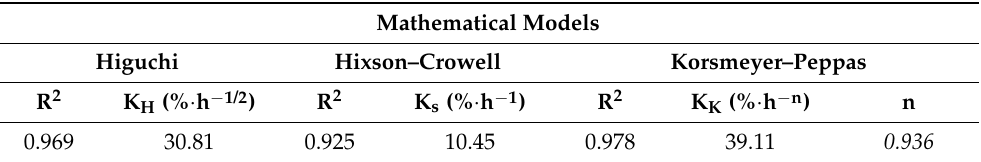
Table 4. Release parameters for GSNO diffusion from PL-HA-GSNO-SiO 2 @CisPt NPs according to